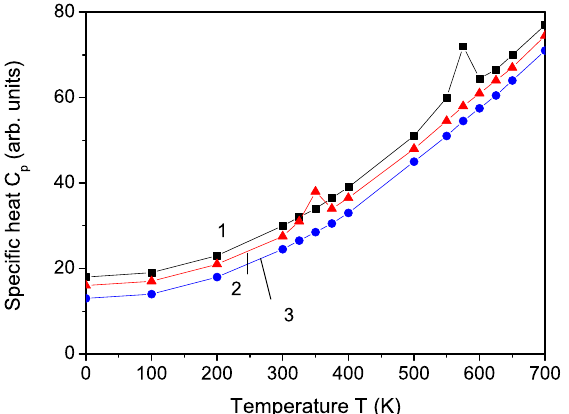
Figure 5. Temperature dependence of the specific heat C p of a MFO NP with N = 10 shells for different magnetic field h values: 0 (1); 20 (2); 60 (3)